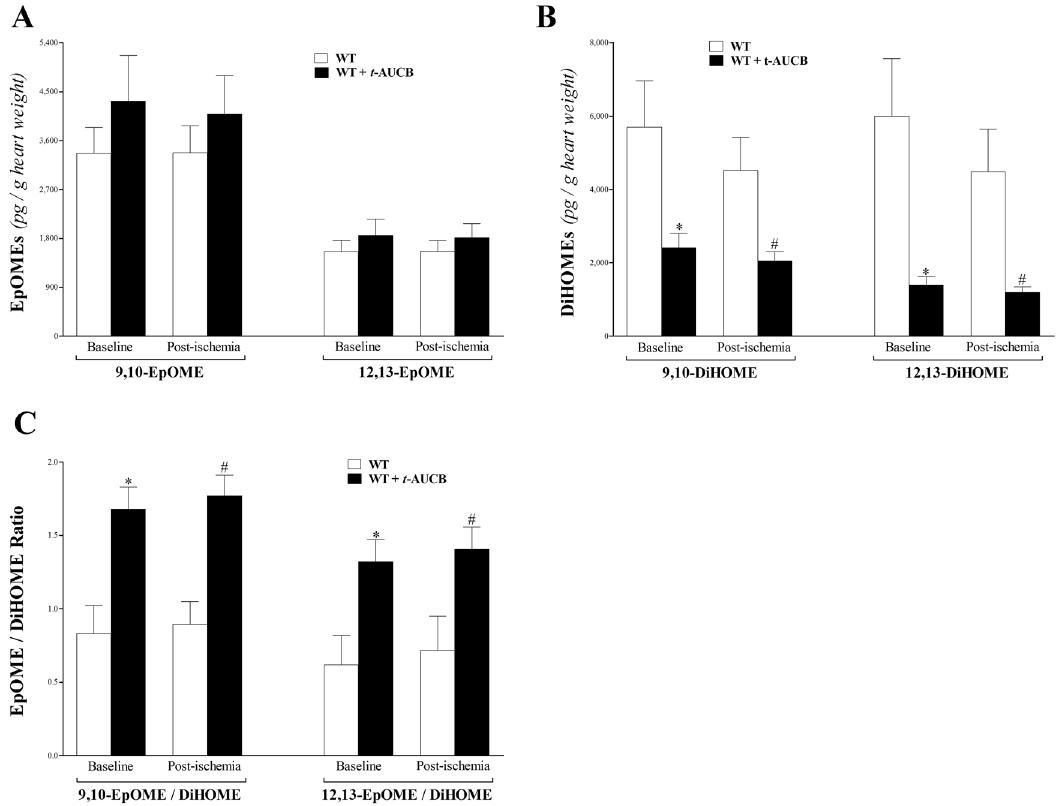
Fig 5. LC – MS/MS analysis of EpOME and DiHOME levels and the EpOME/DiHOME ratio in WT and t- AUCB- treated-WT mouse heart perfusates at baseline (pre-ischemia) and post-ischemia. (A) 9,10- and 12,13-EpOME levels had an increasing trend at baseline and post-ischemia in t- AUCB-treated-WT versus WT mice, but this was not significant (p > 0.05). Neither EpOME was significantly changed post-ischemia compared to baseline in both groups. (B) 9,10- and 12,13-DiHOME levels decreased at baseline and post-ischemia in t- AUCB-treated-WT versus WT mice (p < 0.001). (C) The EpOME/DiHOME ratio increased in t- AUCB-treated versus WT mice at baseline and post-ischemia (p < 0.0001). The measured EpOME and DiHOME levels and EpOME/DiHOME ratio did not change post ischemia versus baseline within the same group (p > 0.05, A-C). * p < 0.05 versus baseline WT. # p < 0.05 versus post-ischemia WT. n =